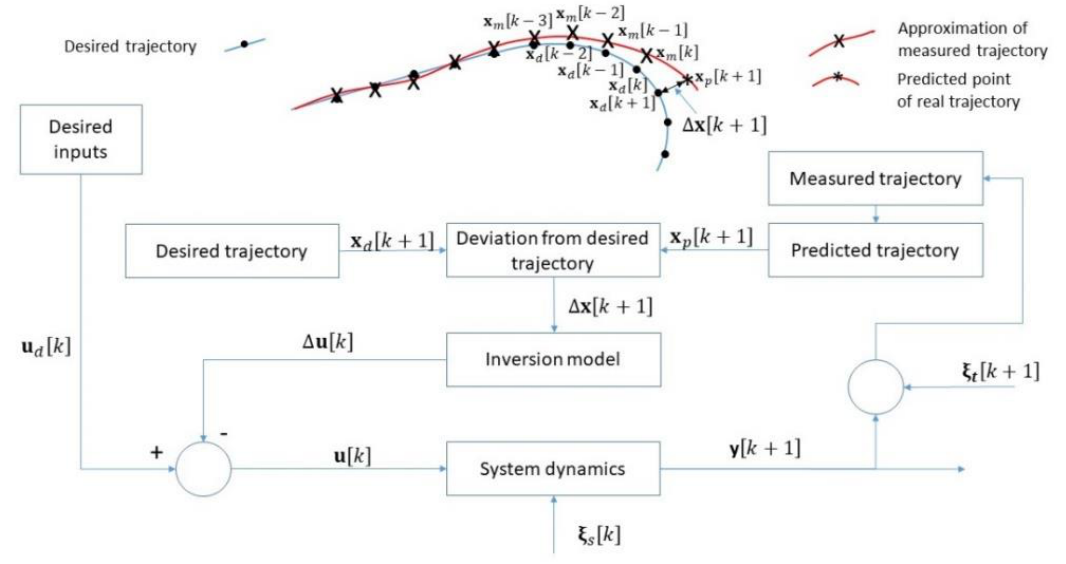
Figure 15. The proposed trajectory following model.